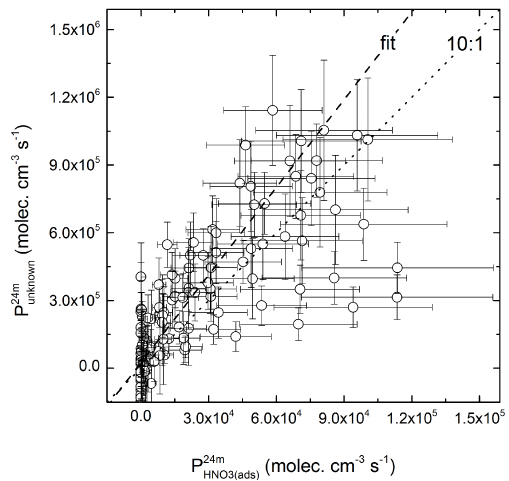
Figure 7. P unknown at the measurement height of 24m during day- time is plotted against the production of HONO from photoly- sis of adsorbed HNO 3 on leaf surfaces, P HNO hancement factor of 43 and a surface loading of (8.3 ± 3.1) × 10 − 5 mol m − 2 , it might explain up to 10% of P unknown , indicated by the 10 to 1 line (dotted line). The York linear fit (York et al., 2004) yields in P unknown = ( 12 . 9 ± 1 . 0 ) × P HNO 10 4 moleculescm − 3 s − 1